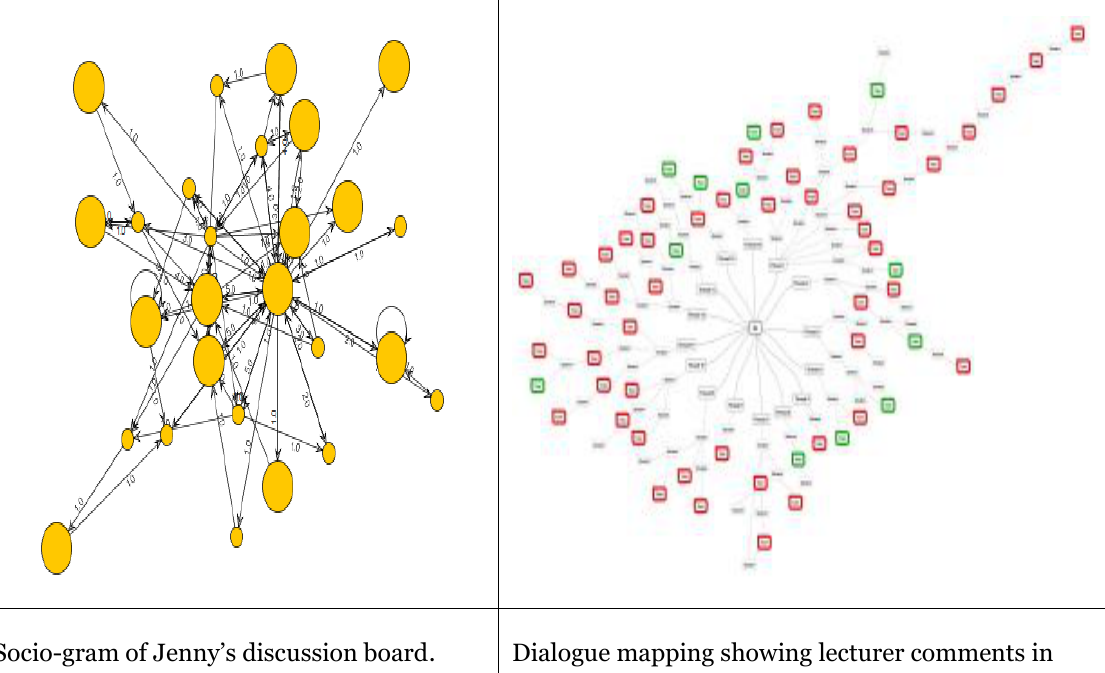
Dialogue mapping showing lecturer comments in bold red (Jenny) and green (Second Module Tutor). Figure 2. Visualisations of a discussion board: